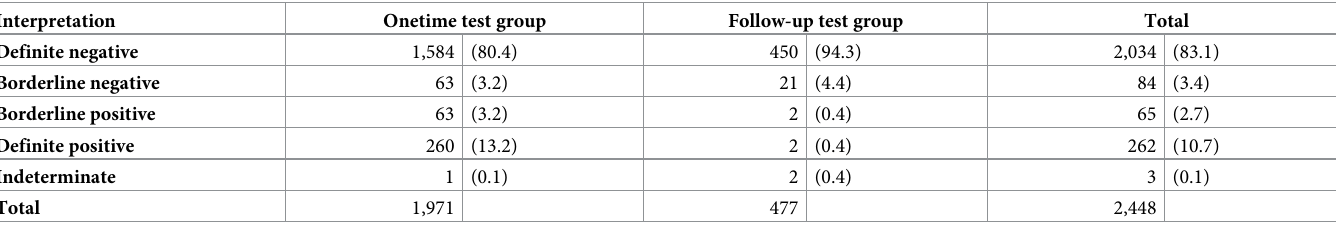
Table 1. Baseline QFT-GIT results of healthcare workers with the borderline